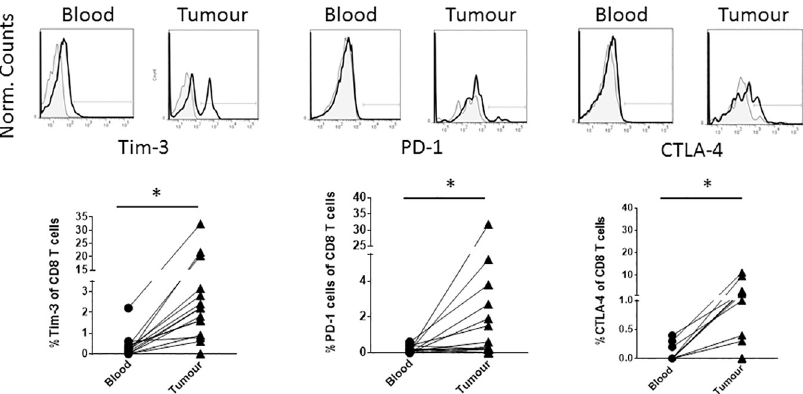
Fig 3. The proportion of CD8 T cells expressing PD-1, Tim-3 and CTLA-4 is elevated in tumour relative to the blood. Upper plots are an example of antibody stainingfor each indicatedreceptor after gating on live, CD45 + , CD3 + , CD8 + cells. Shadedplots represent negativecontrol staining.The lower graphssummarise the percentage of PD-1, Tim-3 and CTLA-4 + cells (after subtractionof negativecontrol percentage staining)for individual patients. The lines connect the matched blood and tumour sample from each individualpatient. * indicatesp < 0.05.